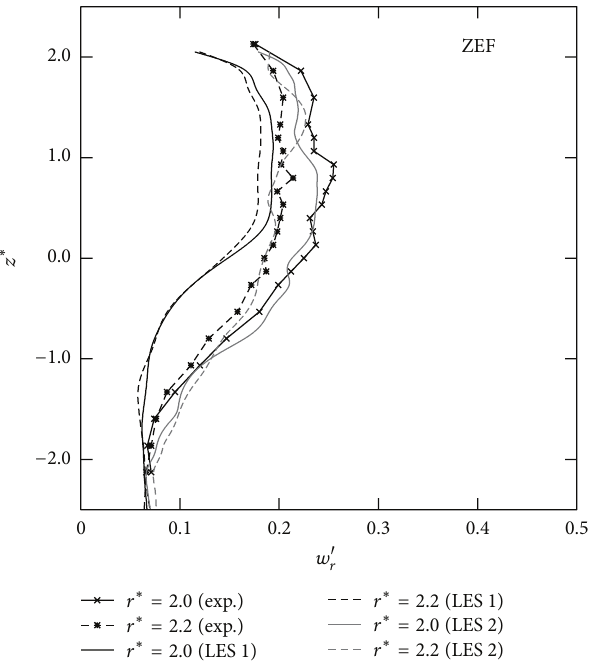
Figure 13: Comparison of axial profiles of r.m.s. values of radial fluctuation velocity in the zone of the established flow